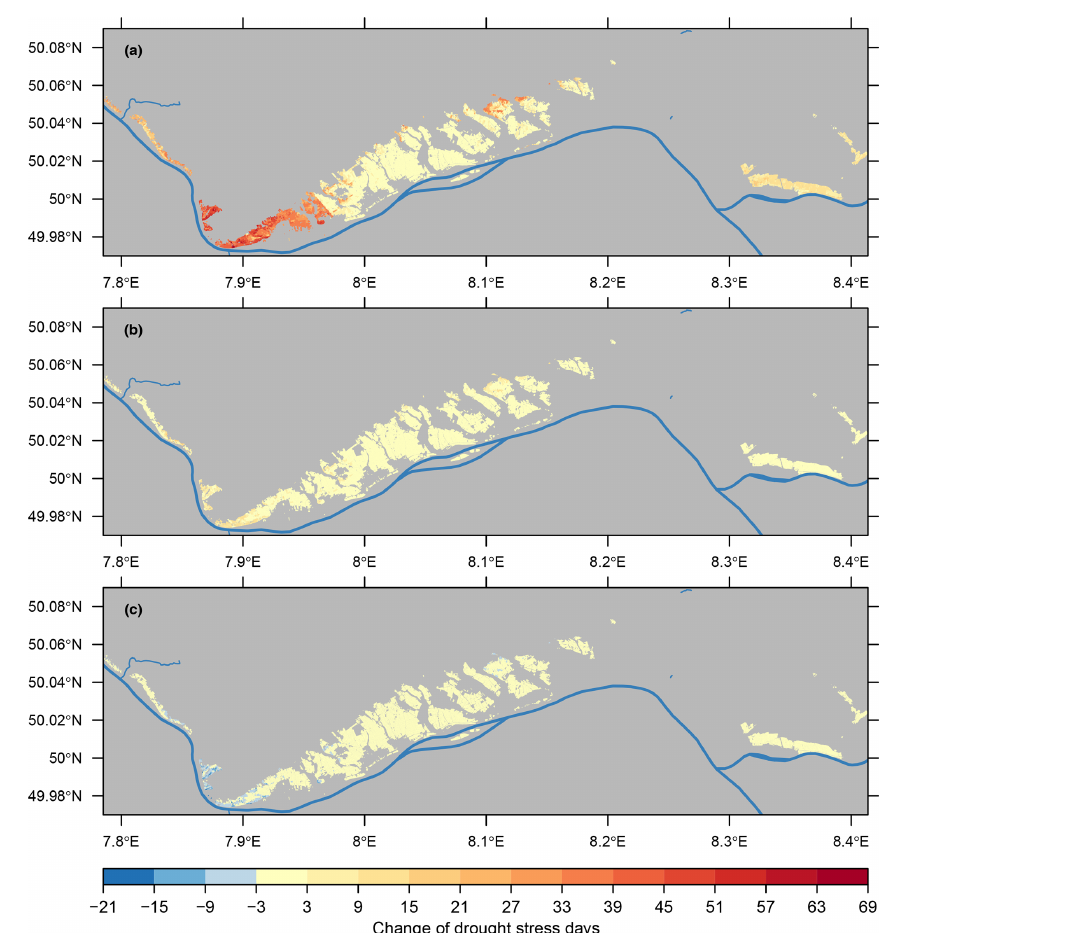
Figure 11. Projected change in the occurrence of drought stress days for the growing region Rheingau (Germany), for the emission scenario RCP8.5, calculated with a water balance model on the assumption of alternating soil cultivation (one row bare soil, one row cover crop). The maps show the difference between the number of the mean drought stress days per vegetation period (1 May–30 September) for the periods 2041–2070 minus 1989–2018 at the spatial scale of the individual vineyard plots. (a) Results of the climate simulation calculating the strongest increase, (b) the simulation close to the ensemble median, and (c) the simulation projecting the strongest decrease in the drought stress area of an ensemble of 10 climate